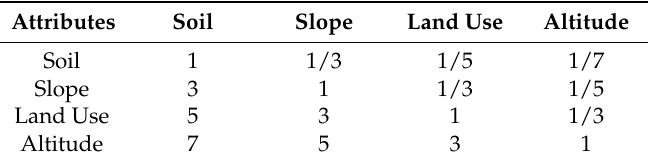
Table 3. Pairwise comparison matrix based on the attribute ranks listed in the last column of Table 1.